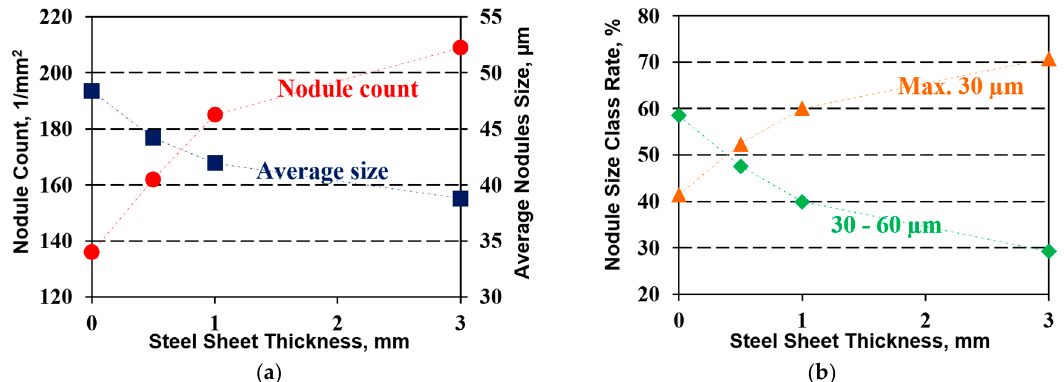
Figure 7. Influence of the steel sheet thickness on the graphite nodules’ characteristics in the casting body: ( a ) nodules’ count and average size; ( b ) nodules size class rate, ISO 945.